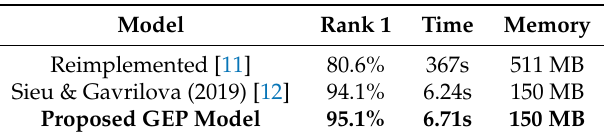
Table 5. Comparison of model time.